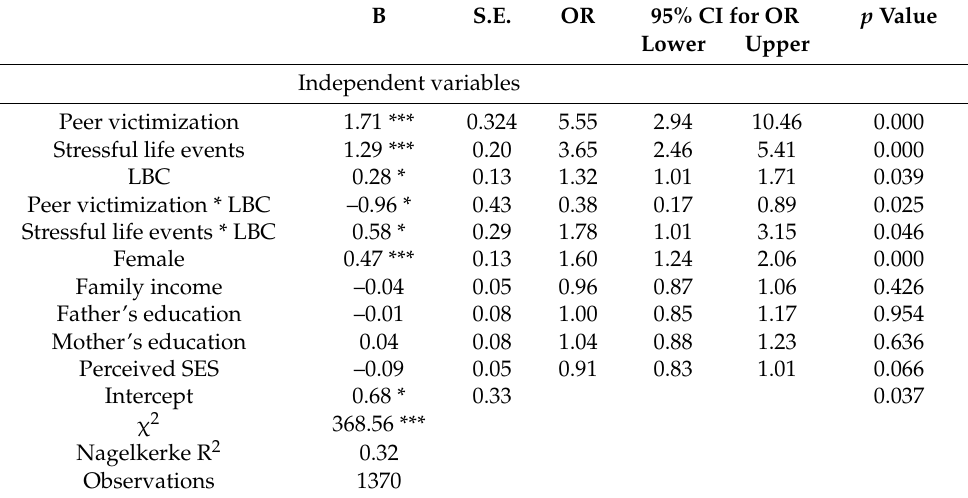
Table 4. Logistic regression estimates of risk factors and left-behind status on depressive symptoms. B S.E. OR 95% CI for OR p Value Lower Upper